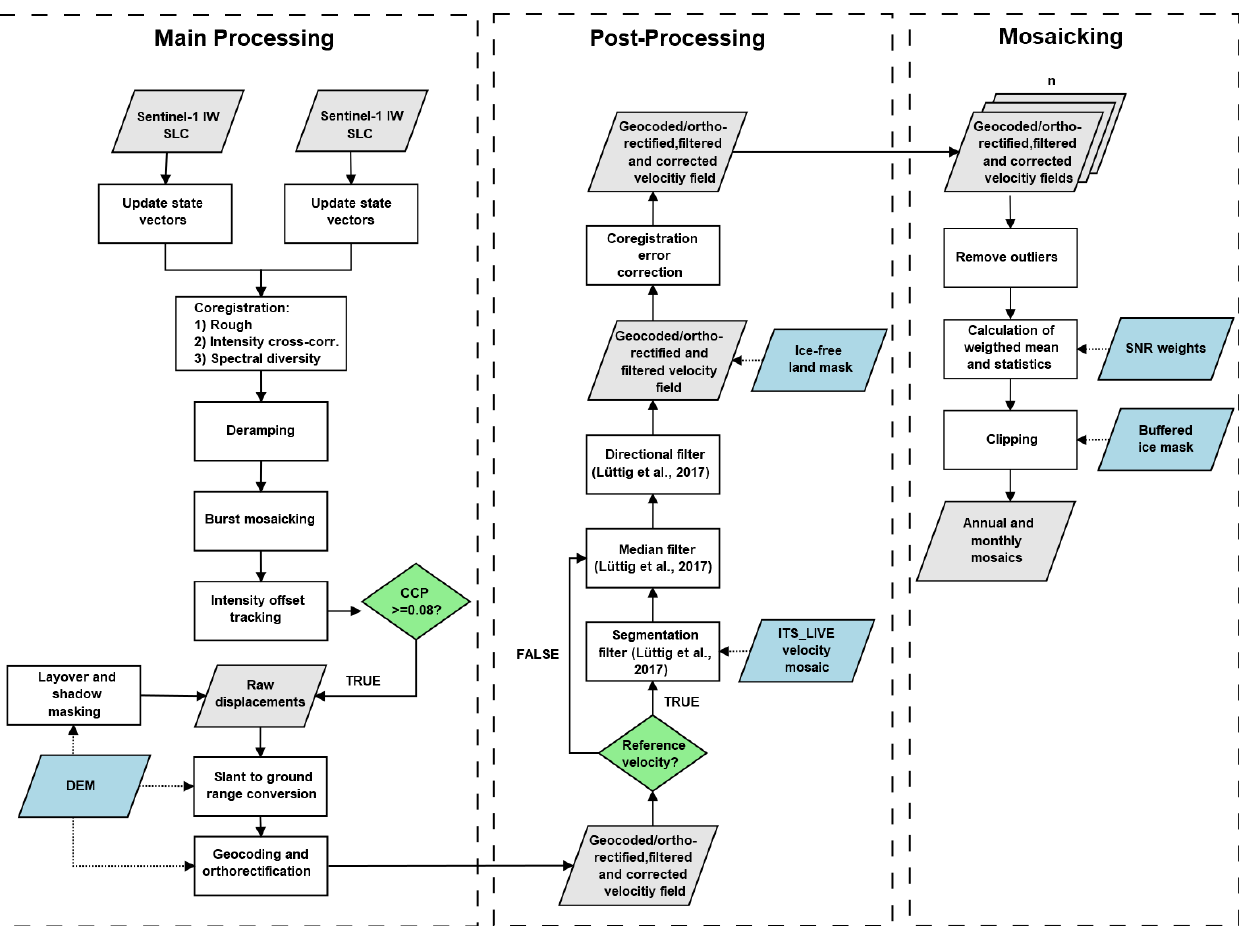
Figure 2. Flowchart of scene-pair velocity field and temporal velocity mosaic